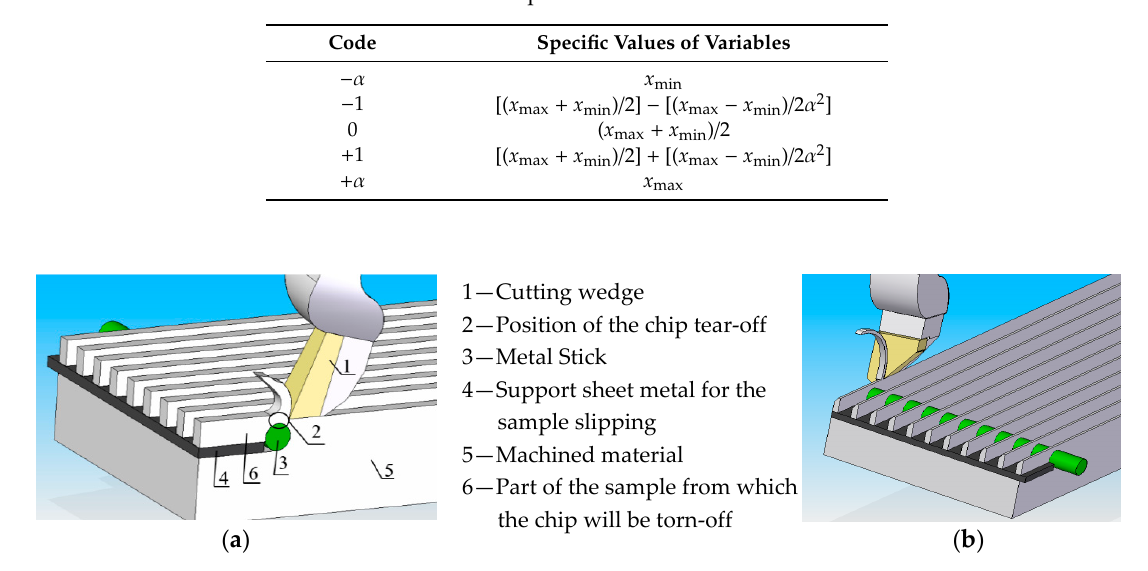
Table 5. The codes for the specific values of individual variables.